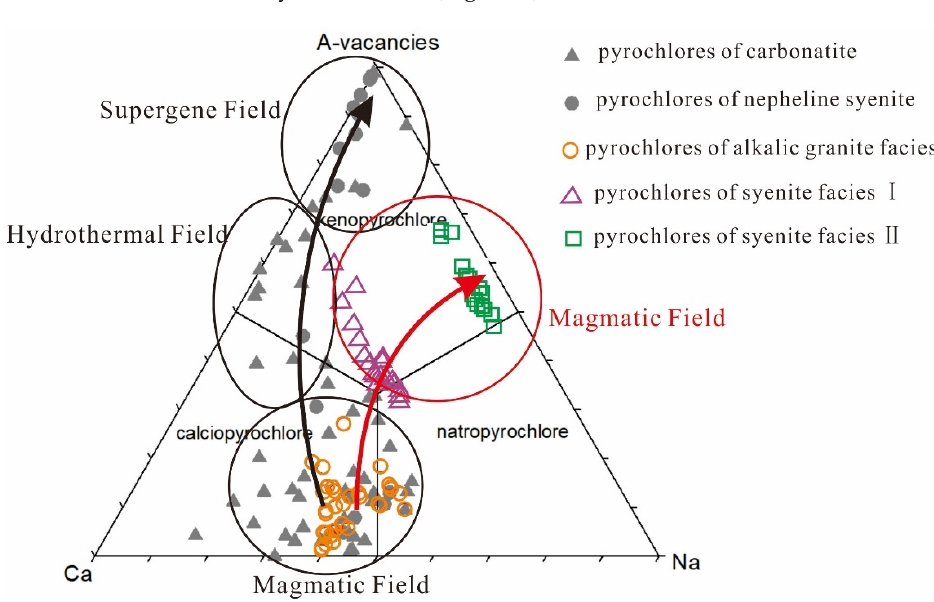
Figure 7. Triangular Nb–Ti–Ta pyrochlore classification scheme (modified by [30,40,66,69,70]).